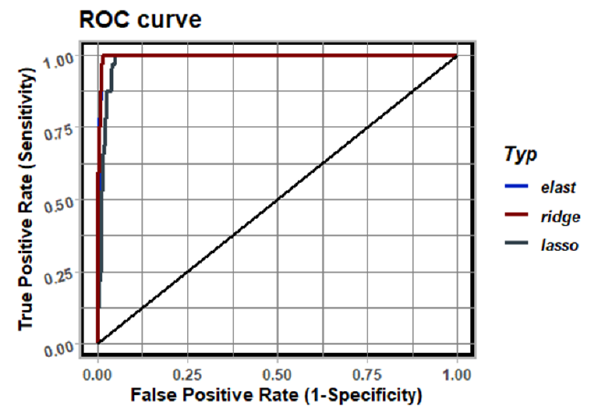
Figure 8. ROC analysis for results shown in Figure